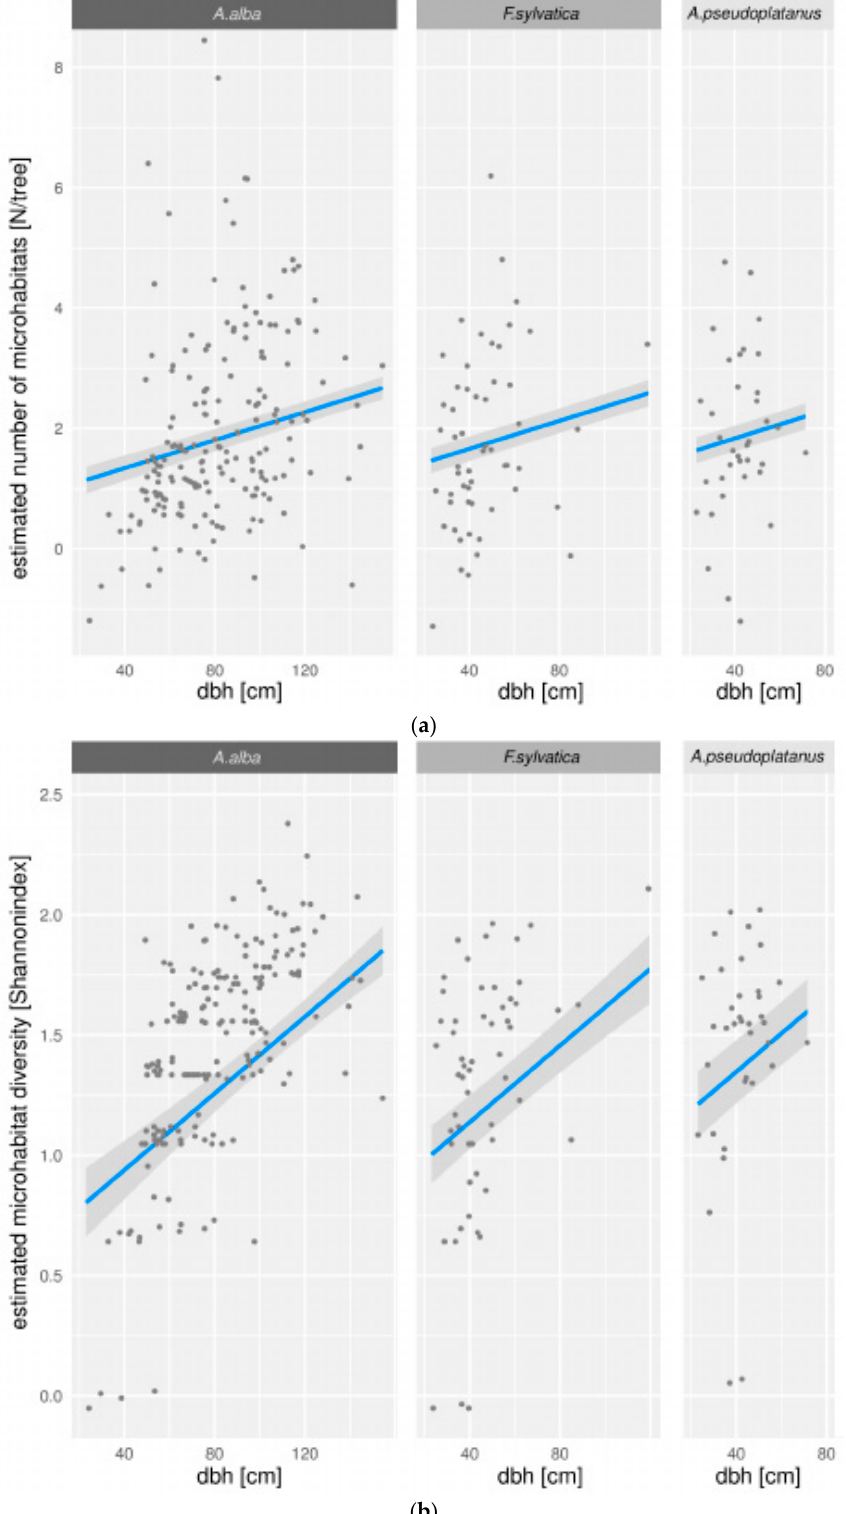
Figure A1. Visualization of the best models for predicting the tree-level number of microhabitats ( a ) and microhabitat diversity ( b ). The blue line is a linear regression curve with a confidence band showing the impact of dbh on the response variable for each tree